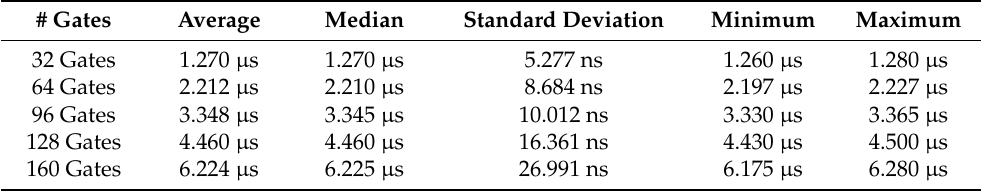
Table 1. Comparison between times for signal propagation for networks with powered gate ICs.